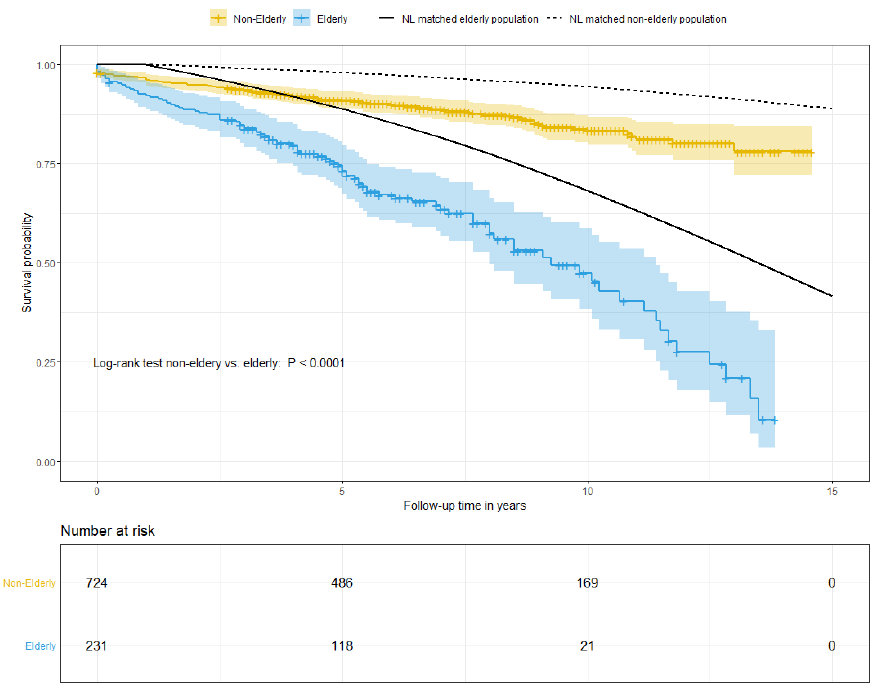
Figure 2. Kaplan–Meier Survival Analysis. Kaplan–Meier survival analysis for the elderly (blue) versus the non-elderly (yellow).